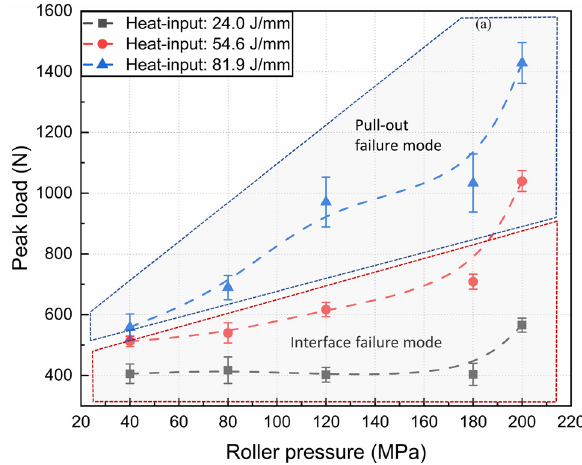
Figure 7: Effect of welding parameters on peak load of laser pres- sure welds during tensile shear